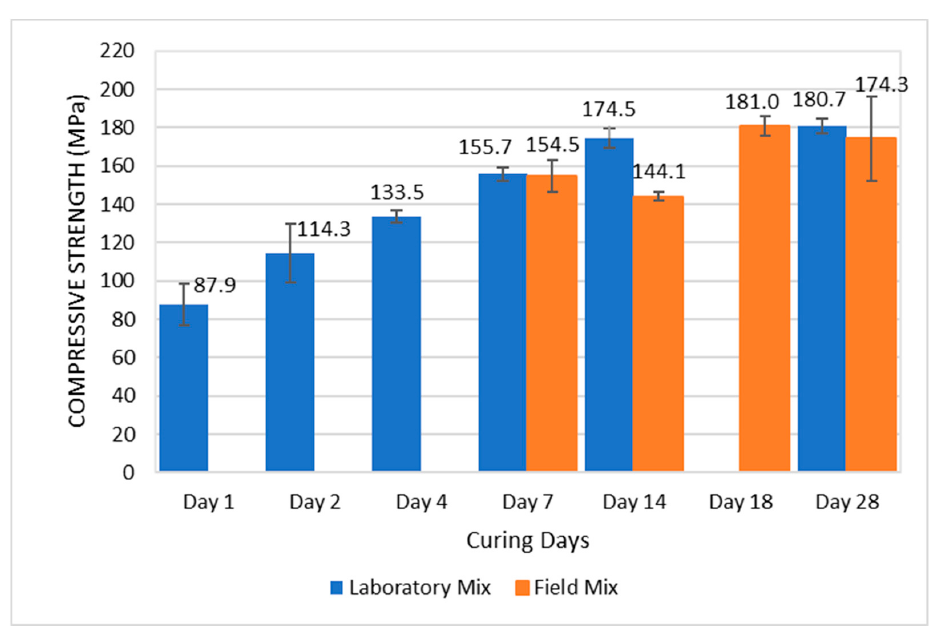
Figure 3. Averages and standard deviations of compressive strengths of laboratory and field mixes for 66 UHPC specimens.